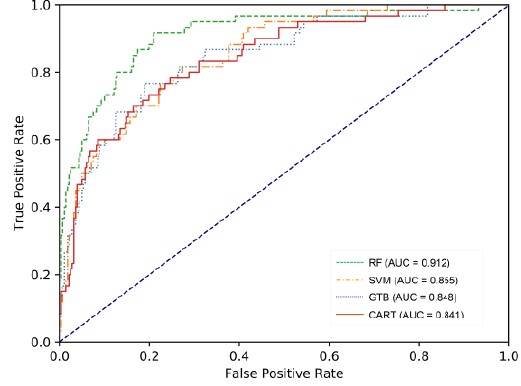
Figure 12 . Average ROC curves for the classifiers. GTB with OA=86.4% and Kappa=0.836, and CART with OA=85.3% and Kappa=0.822 presented the least performances compared to RF and SVM. However, both classifiers were stable in performance with minimal variability in the multitemporal classification accuracy. The lower performance by CART has been attributed to the decision trees being too sensitive to small changes in the training datasets and tends to overfit the model (Prasad et al., 2006). The results of the current study also point to the fact that CART is sensitive to variable input data which is attributed to the classifier having a single threshold for defining a node for splitting data into subsets.